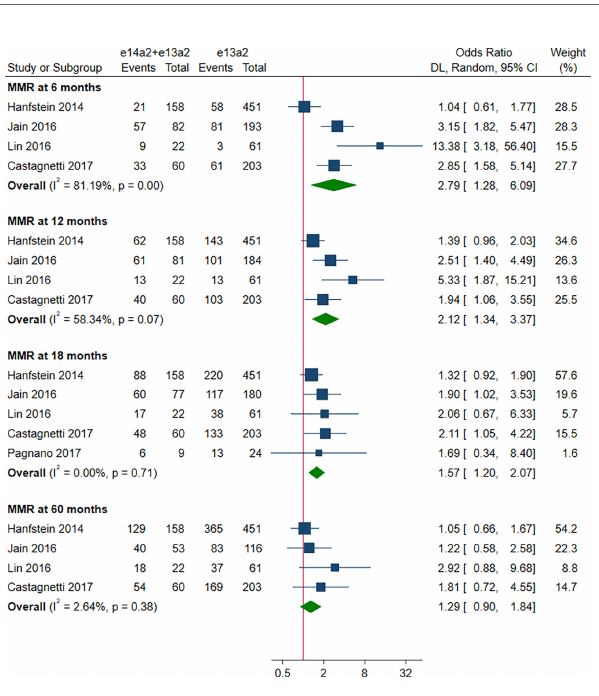
FIGURE 3 | E14a2 + e13a2 versus e13a2: rate of patients who achieved major molecular response at 6, 12, 18 and 60